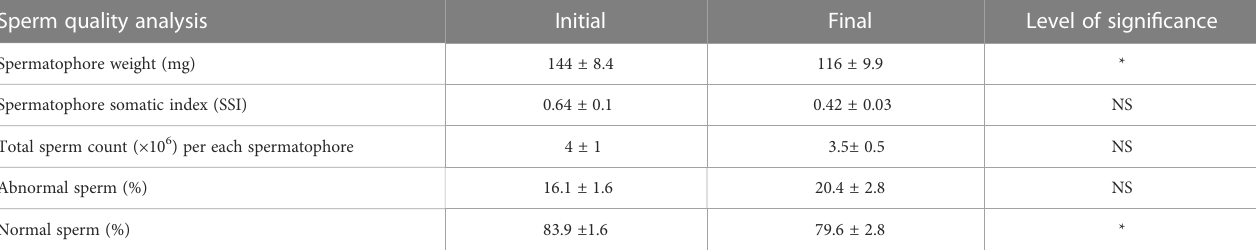
TABLE 4 Total sperm counts and percentage of normal and abnormal sperm (mean ± SE) in captive-reared male Penaeus indicus in the indoor maturation units before and after maturation cycle during trial II based on independent sample-T test. Sperm quality